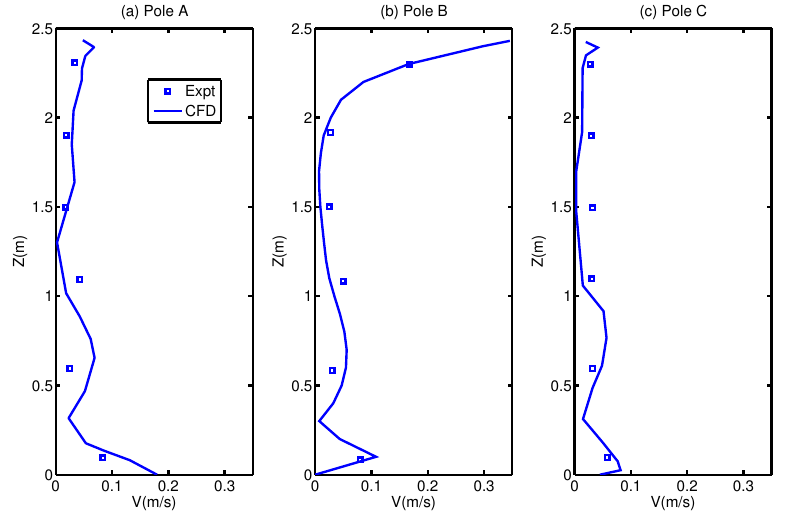
Figure 6. Velocity comparisons between the CFD results and experimental data at: ( a ) Pole A; ( b ) Pole B; and ( c ) Pole